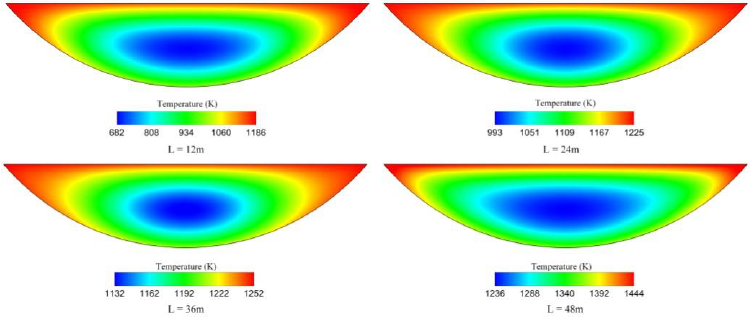
Figure 6. Temperature distribution of the solid phase within the bed cross-section.